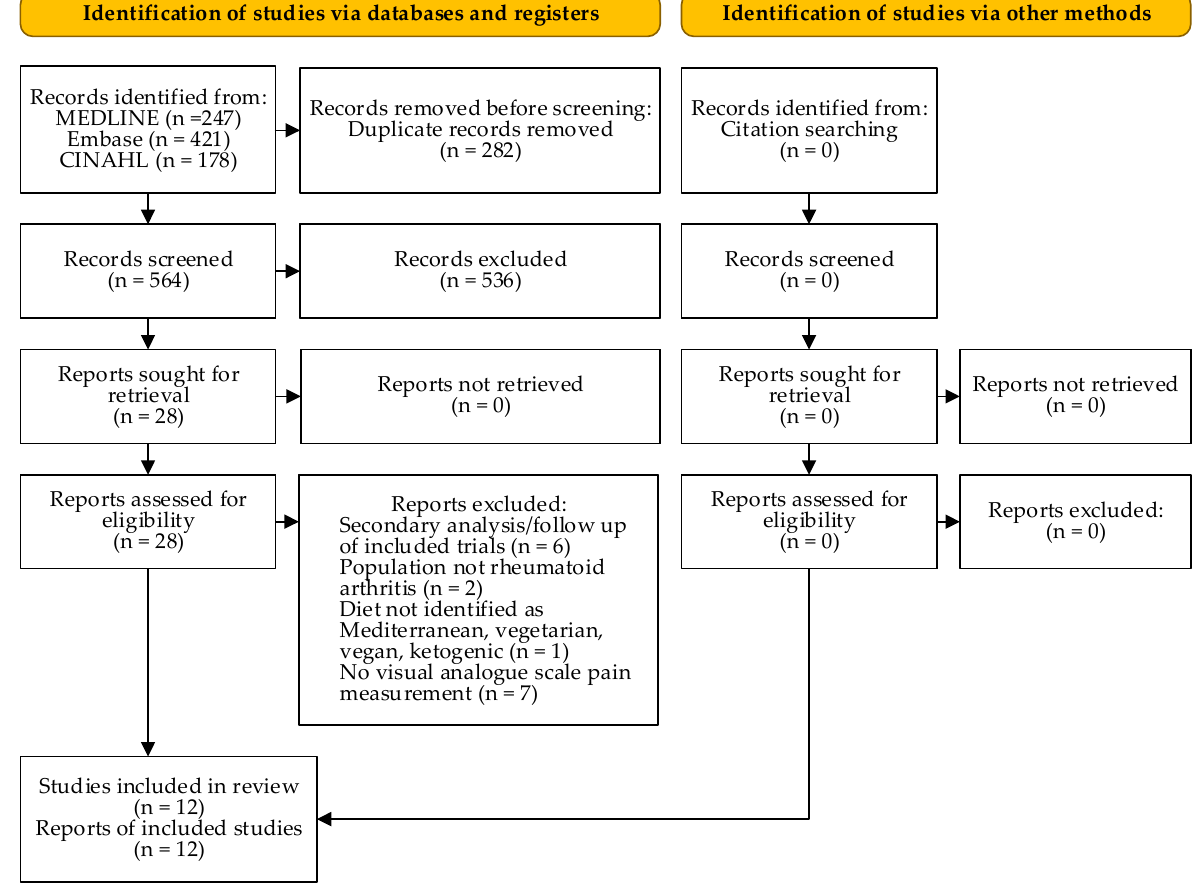
Figure 1. PRISMA flow diagram (according to [16]).